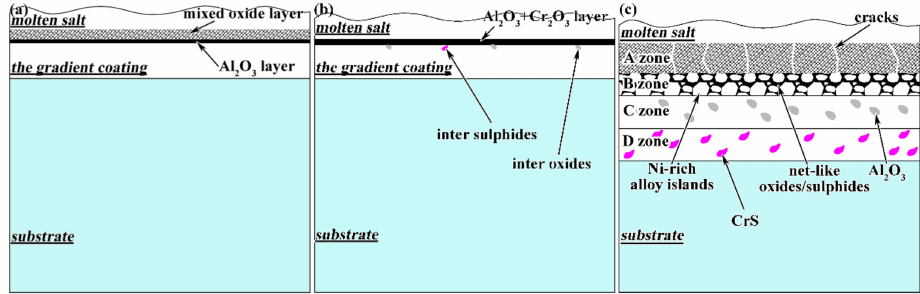
Figure 12. Degradation scheme of the preoxidised coating by hot corrosion at 900 ◦ C: ( a ) the as- received state, viz., 0 h; ( b ) after 120 h; ( c ) after 220